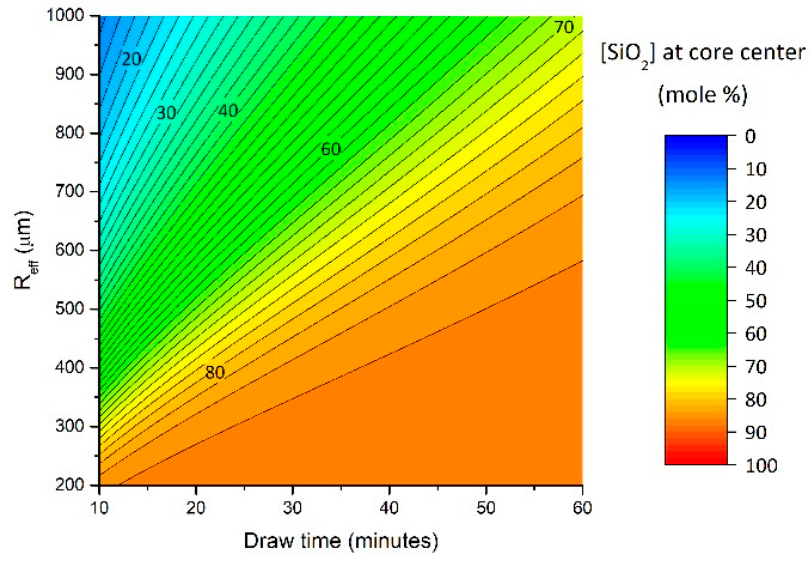
Figure 4. Changes in SiO 2 concentration at the final fiber core center as a function of the effective radius ( R eff ) during fiber drawing. Fiber is collected typically 10–15 min after the sample is in the furnace, which sets the lowest draw time bound.